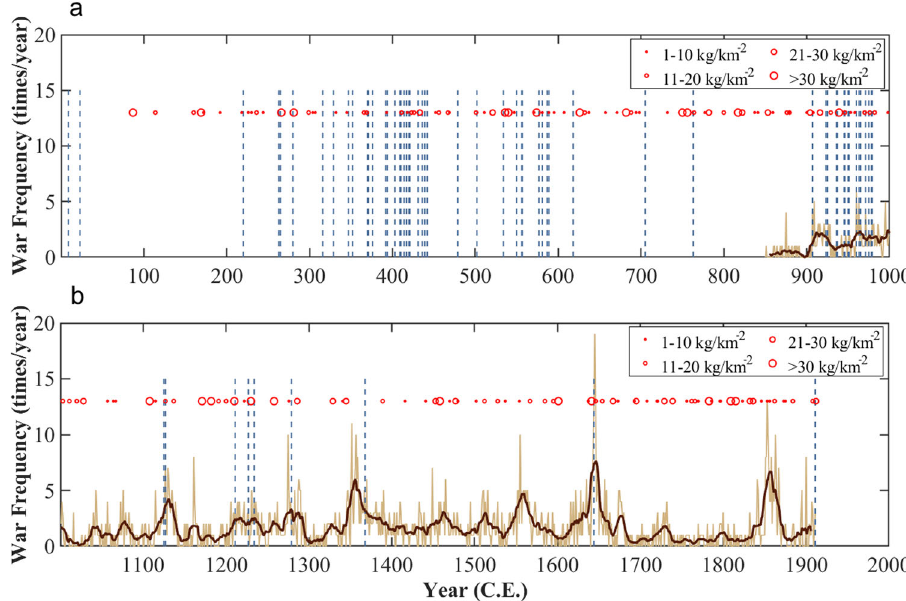
Fig. 1 Chinese dynastic collapse, explosive volcanism, and warfare frequency, 1 – 1911 CE. Consensus dates for 68 dynastic collapses (blue dashed vertical columns; Supplementary Data 1), overlain by ice-core-based dates and climate forcing potential of inferred-tropical and extratropical Northern Hemispheric explosive volcanic eruptions ( n = 156) as inferred by multi-ice-core measurements of polar sulfate deposition (in kg/km − 2 ) 42 (graduated red circles), for 1 – 1911 CE. Also shown is annual warfare frequency from 850 to 1911 CE 12 (continuous tan line), with the thick brown line representing a 10-year smoothing using the Savitzky-Golay fi lter. The fi gure is split into two consecutive periods for visual clarity; a and b cover the fi rst and second millennia CE,